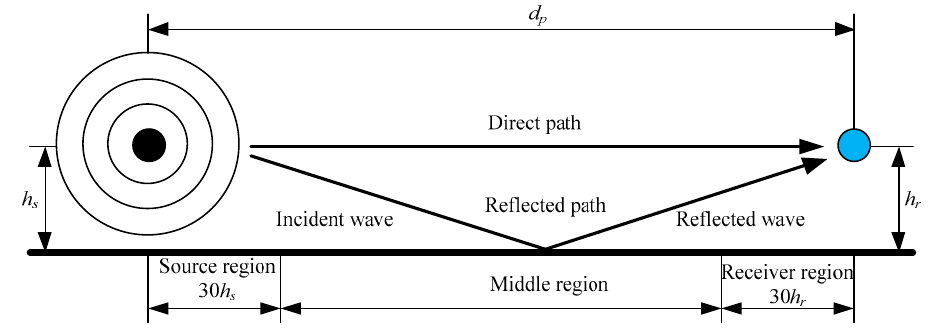
Figure 3. Effect of ground on the received sound pressure level.